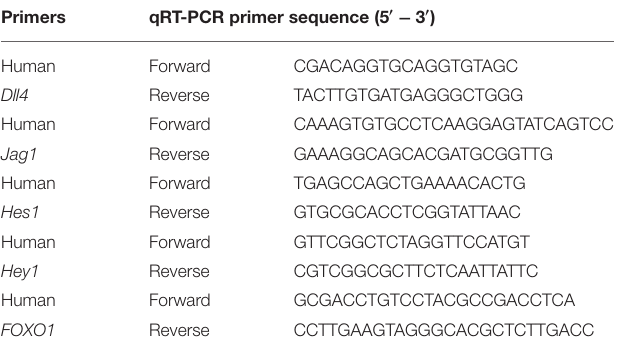
TABLE 2 | Sequencing information of qRT-PCR primers.